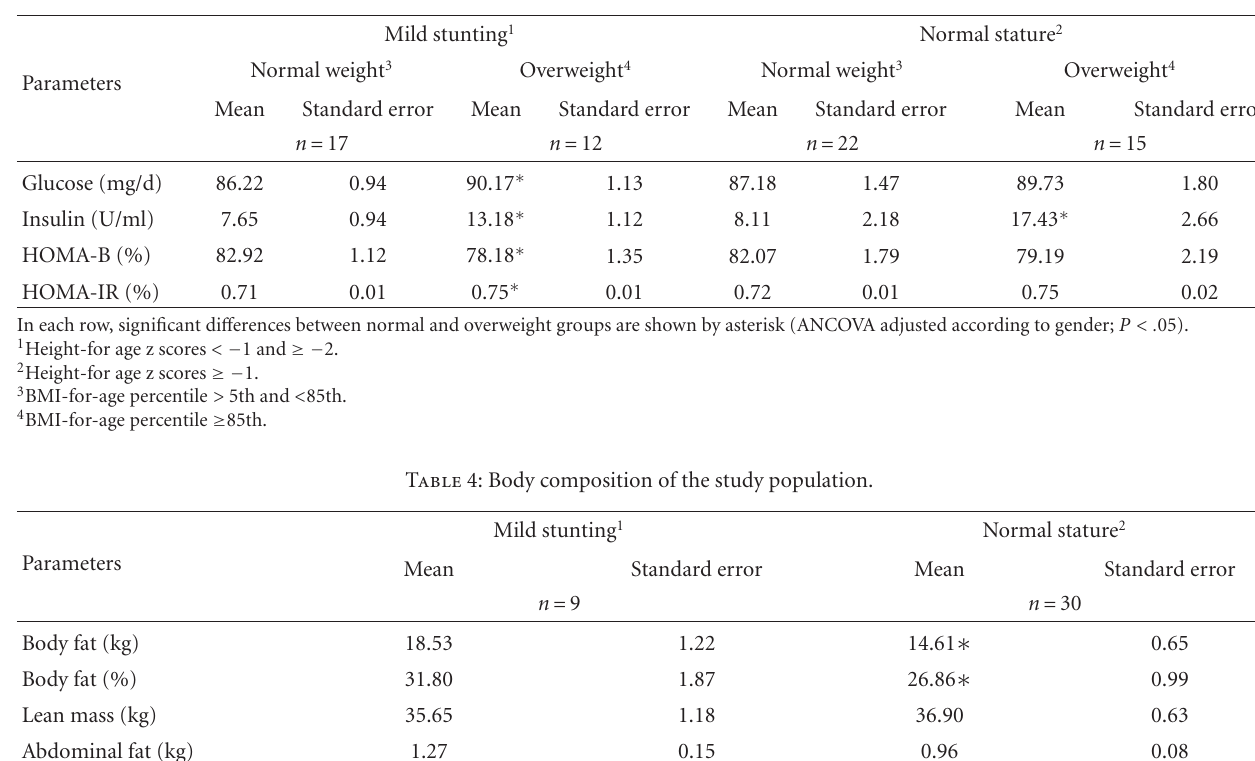
Table 3: Biochemical characteristics of the study population.